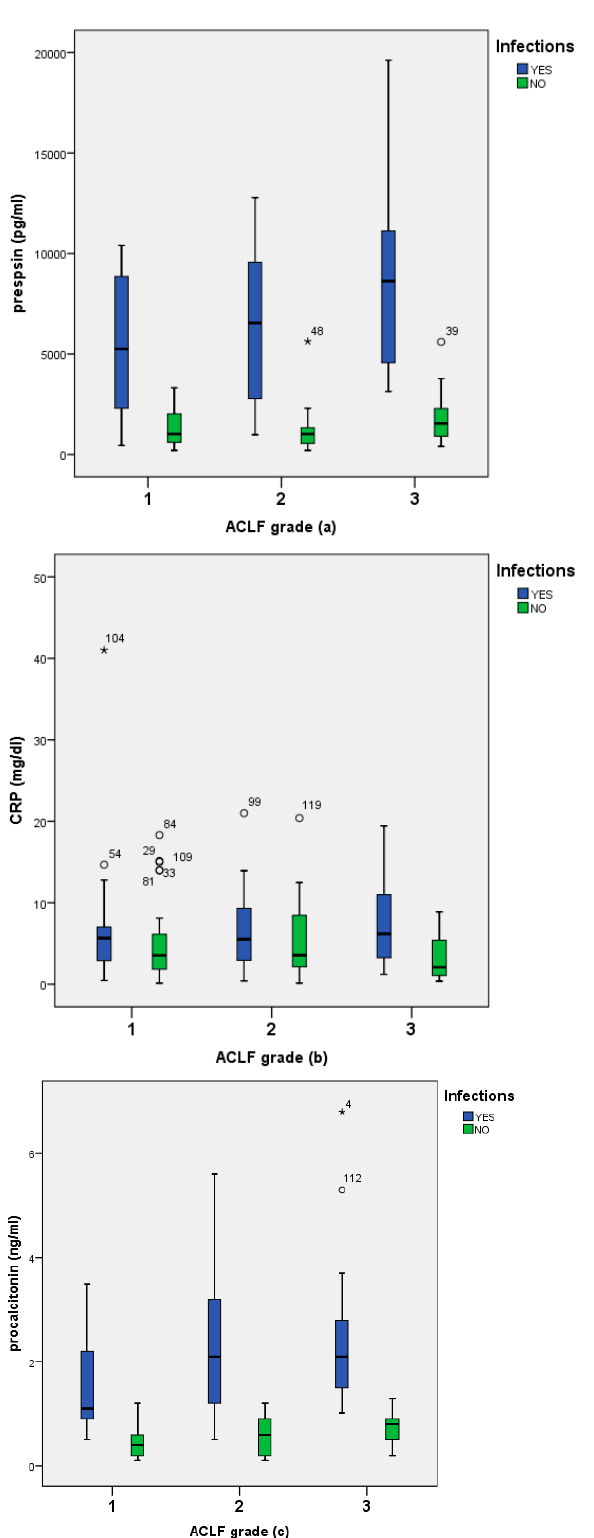
Figure 2. Presepsin ( a ), CRP ( b ), and procalcitonin ( c ) levels among patients with ACLF, with or without infections.